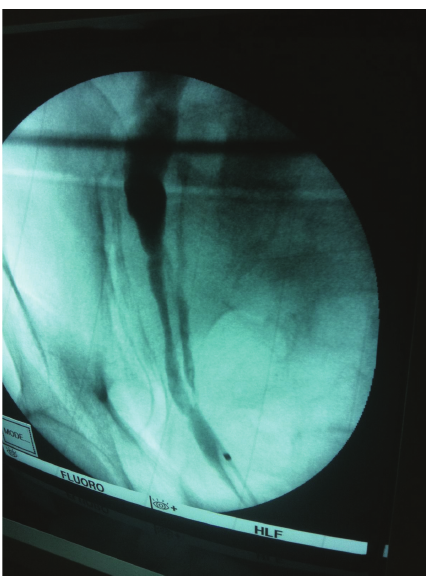
Figure 1: Retrograde pyelography showing H-shaped